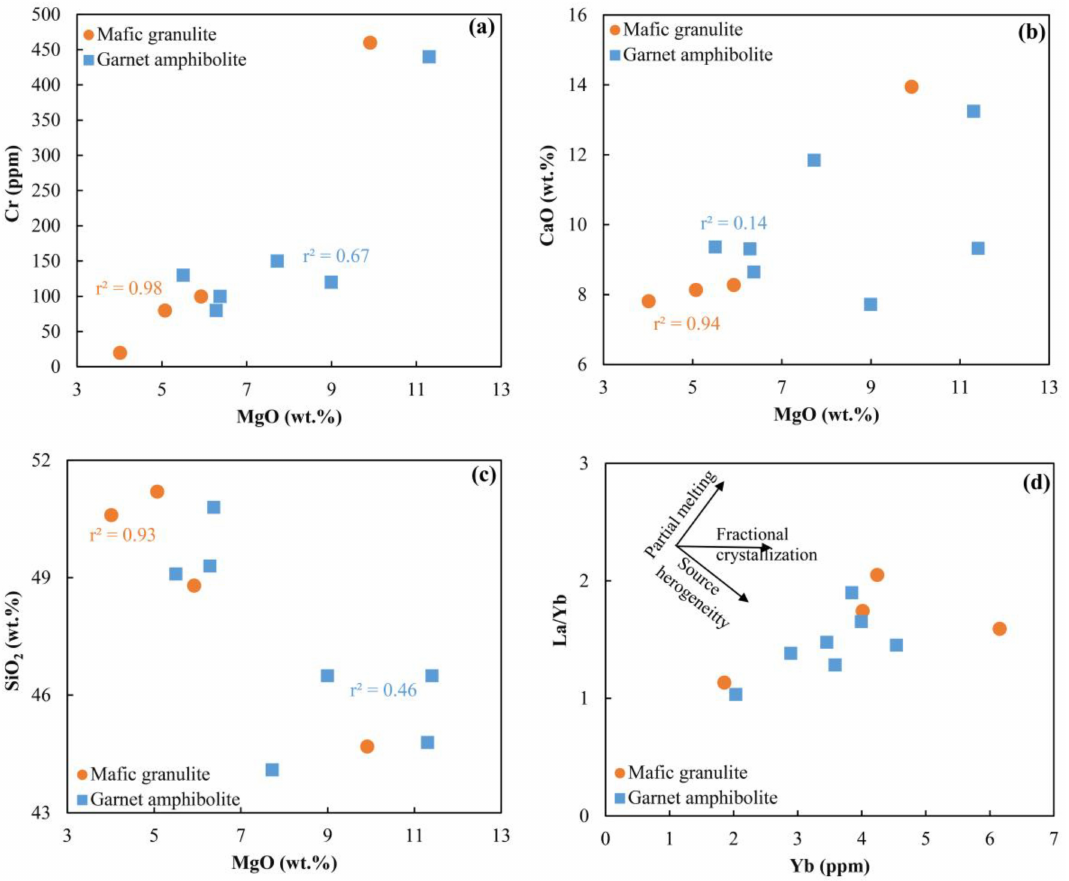
Figure 13. Binary plots of ( a ) Cr vs. MgO; ( b ) CaO vs. MgO; ( c ) SiO 2 vs. MgO; and ( d ) Yb vs. La/Yb